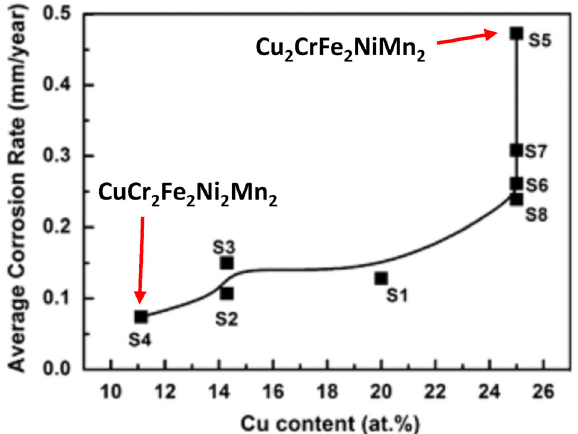
Fig. 9 Effect of Cu content on the corrosion rate (calculated from immersion tests) of different CuCrFeNiMn alloys (reprinted from ref. 59 with permission of John Wiley and